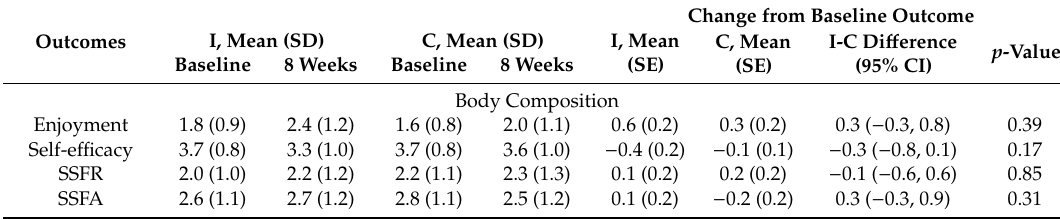
Table 4. Estimated Treatment E ff ects on Psychosocial